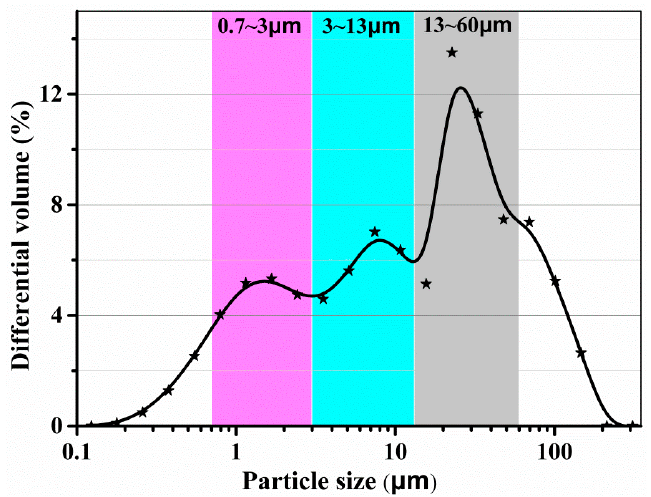
Figure 1. Particle size distribution of the SAC.